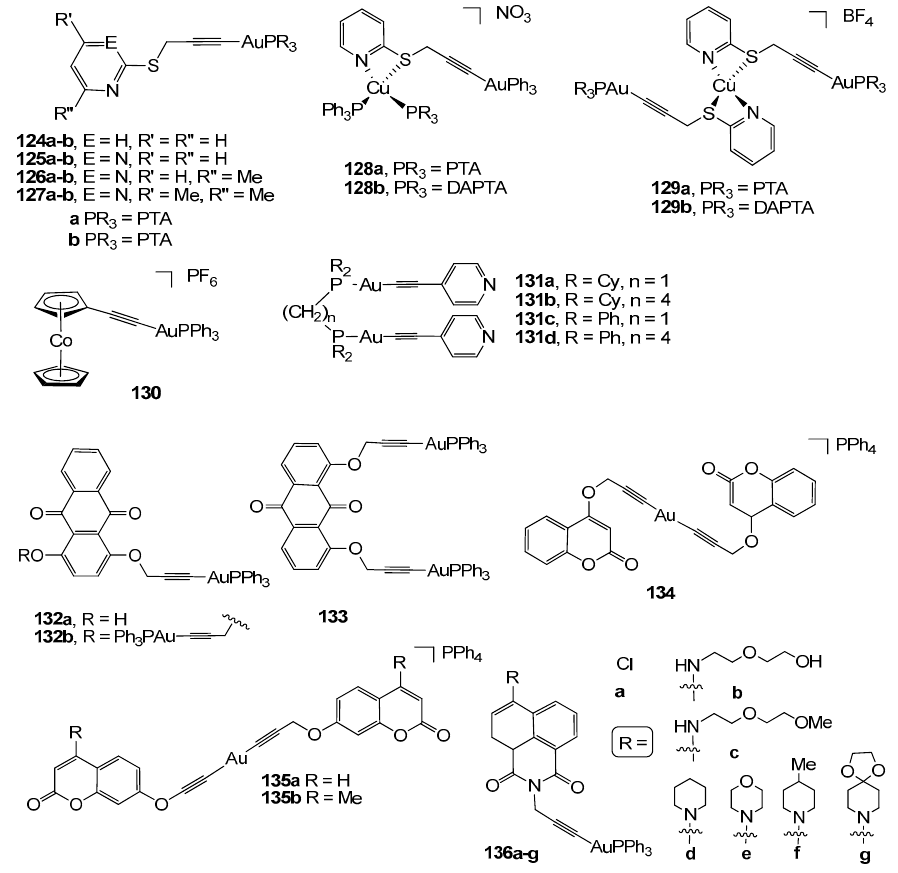
Figure 9. Mono and polinuclear alkynyl gold(I) derivatives.